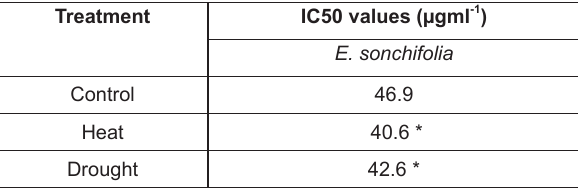
Table 3. IC 50 values of E. sonchifolia